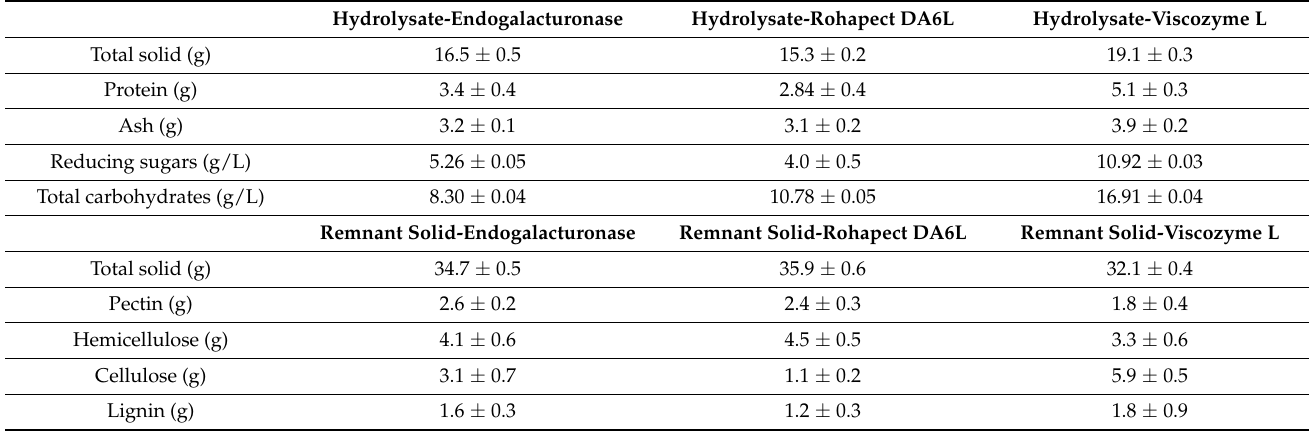
Table 2. Characterization of oligosaccharide extract obtained with commercial enzyme